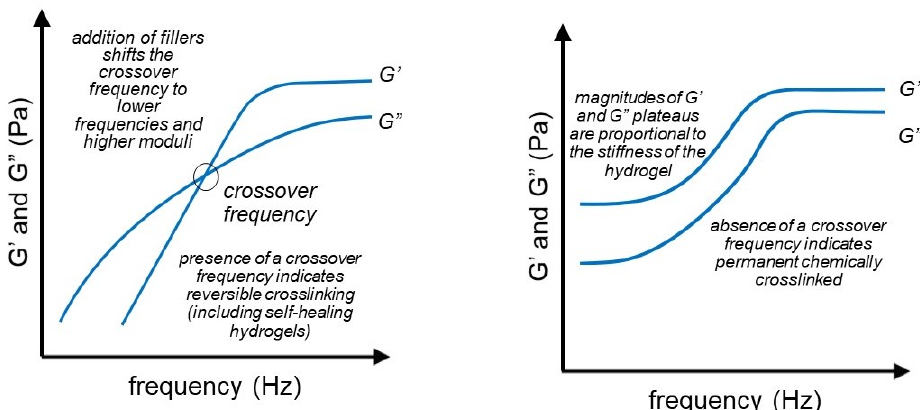
Figure 7. Frequency sweep experiments are a powerful tool in rheology of hydrogels which show the crosslinking behavior as well as the presence of a reversible network.